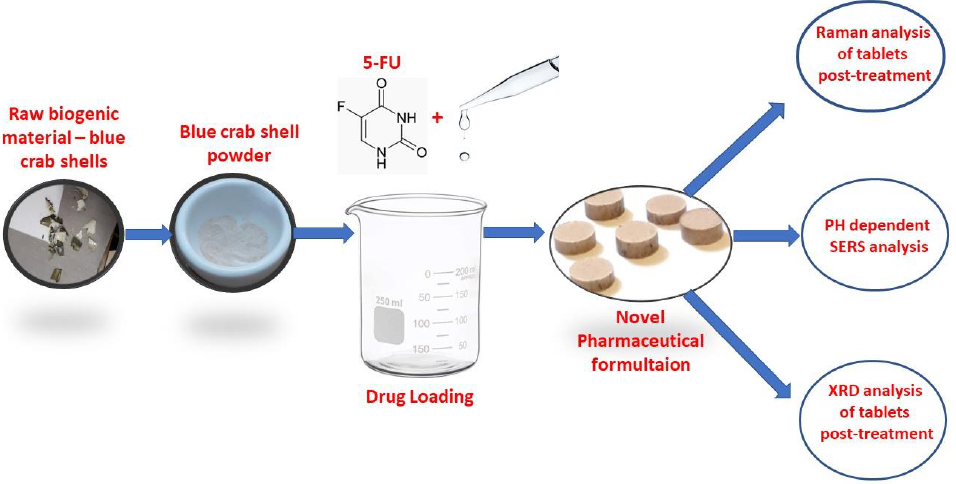
Figure 1. Schematic design of the biogenic calcite drug carrier for loading the 5-FU and the pH effect on the tablet and its slow-releasing active ingredient. on the tablet and its slow-releasing active ingredient.